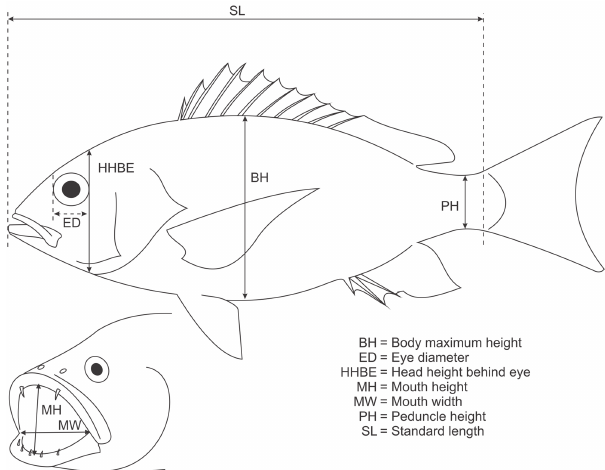
Fig. 1. Morphometric measures used for the study.